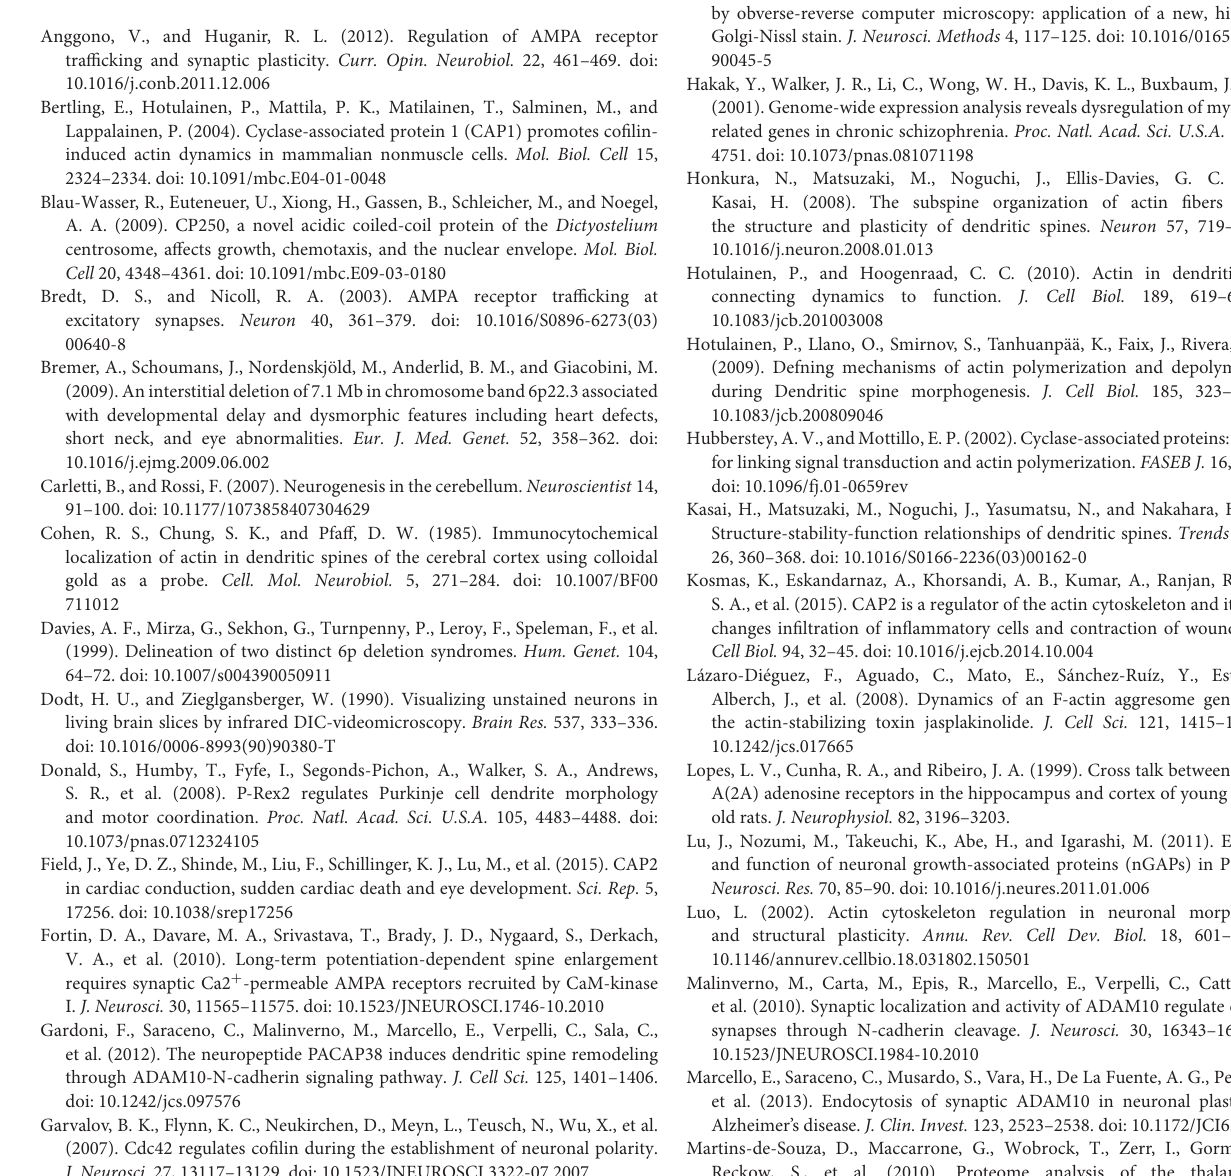
FIGURE S1 | (A) X-gal staining for Cap2 + / gt brain shows a widespread distribution of CAP2. The major anatomical regions of brain olfactory bulb (OB), cortex (Ctx), hippocampus (Hpf), and cerebellum (Cbl) are depicted. Scale bar, 1 mm. (B) CAP2 is expressed in cortex, hippocampus and cerebellum. Paraffin embedded brain sections were stained with CAP2 monoclonal antibodies (K82-381-1) and a widespread expression profile was observed in mice brain (Scale bar, 20 µ m). (C) CAP2 is expressed in the neuronal dendritic shaft as revealed by coimmunostaining with MAP2. (D) Cortical neurons were labeled with antibodies against CAP2 and synapsin I, a presynaptic marker, revealing the presence of CAP2 at presynaptic terminals (white arrows in inset). FIGURE S2 | (A) Western blot analysis for brain lysate with polyclonal CAP2 antibody. (B) Immunofluorescence analysis with brain section from WT and CAP2 mutant mice revealed complete deletion of CAP2 from brain (Scale bar, 20 µ m). (C) Primary cortical neurons from WT and CAP2 mutant mice transfected